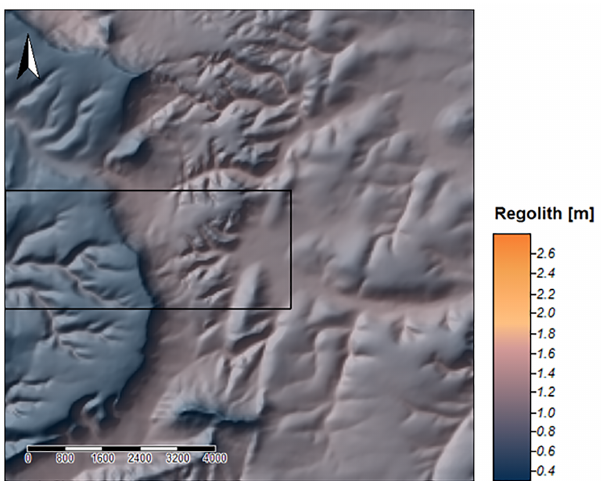
Figure 9. First results of the SaLEM simulation in Ebergötzen showing the distribution of regolith thicknesses resulting from 50ka modeling including allochthonous input (loess). The rectangle indi- cates the area where a first validation of the results was conducted.